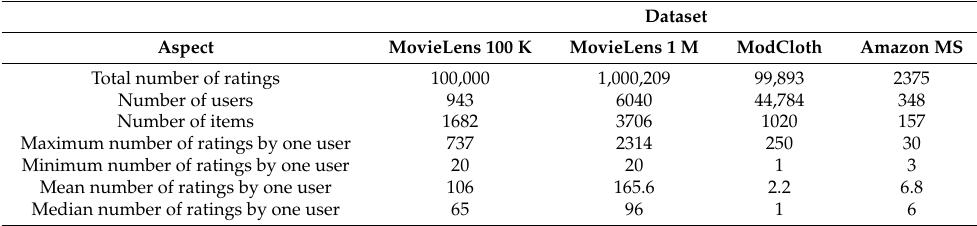
Table 1. Datasets